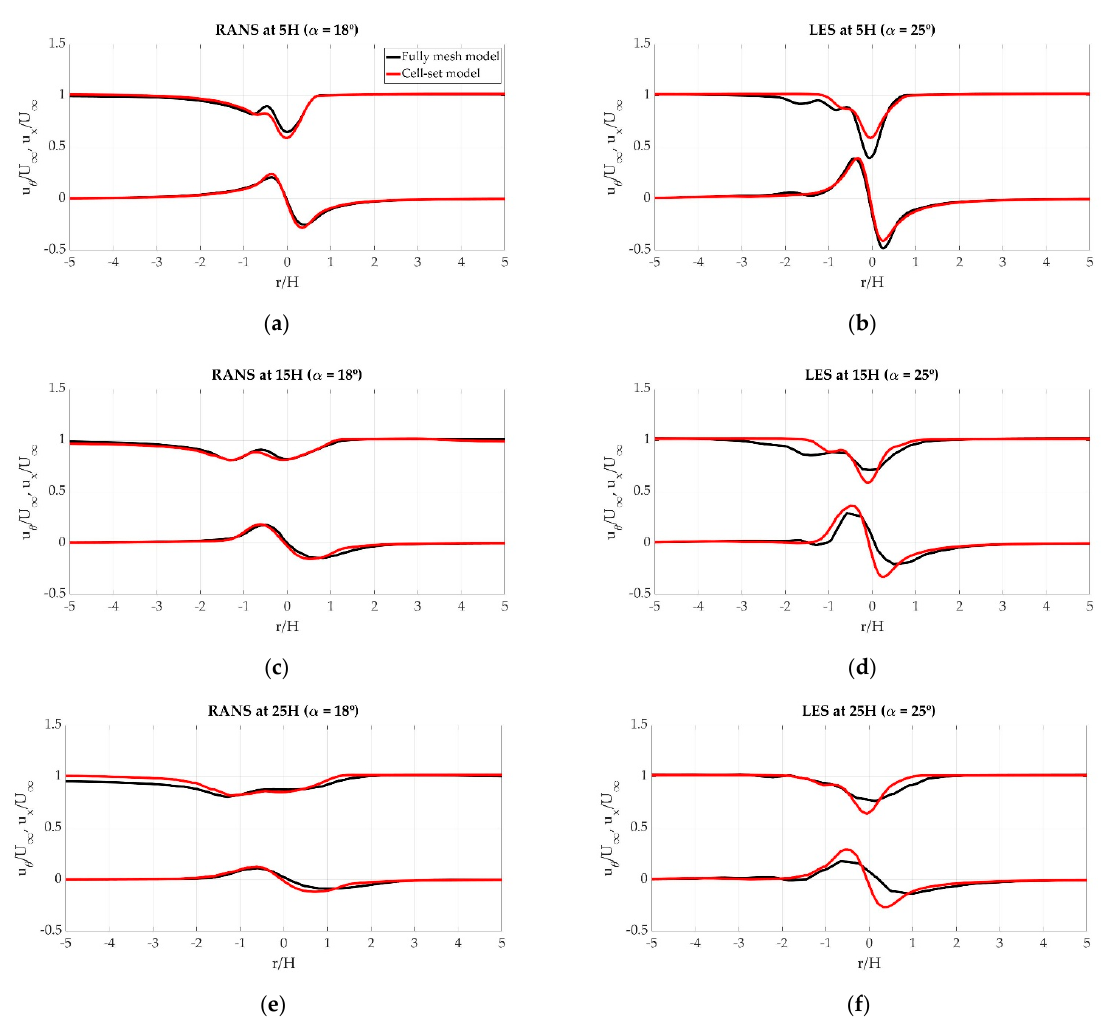
Figure 8. Normalized axial (upper) and azimuthal (lower) velocity profiles: ( a ) RANS at 5H from the VG Leading Edge; ( b ) LES at 5H; ( c ) RANS at 15H; ( d ) LES at 15H; ( e ) RANS at 25H; ( f ) LES at 25H.